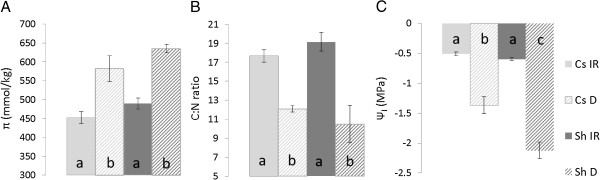
Physiological adjustment in response to stress. (A) Osmolality (π), (B) Carbon/Nitrogen ratio (C:N) and (C) leaf water potential (Ψl) of Cabernet Sauvignon (Cs) and Shiraz (Sh) on day 34 of the experiment. Columns represent means ± SE (n = 6) and different letters represent significant difference between irrigated (IR) and water deficit (D) treatment as tested by the Student’s t-test (p-value < 0.05).